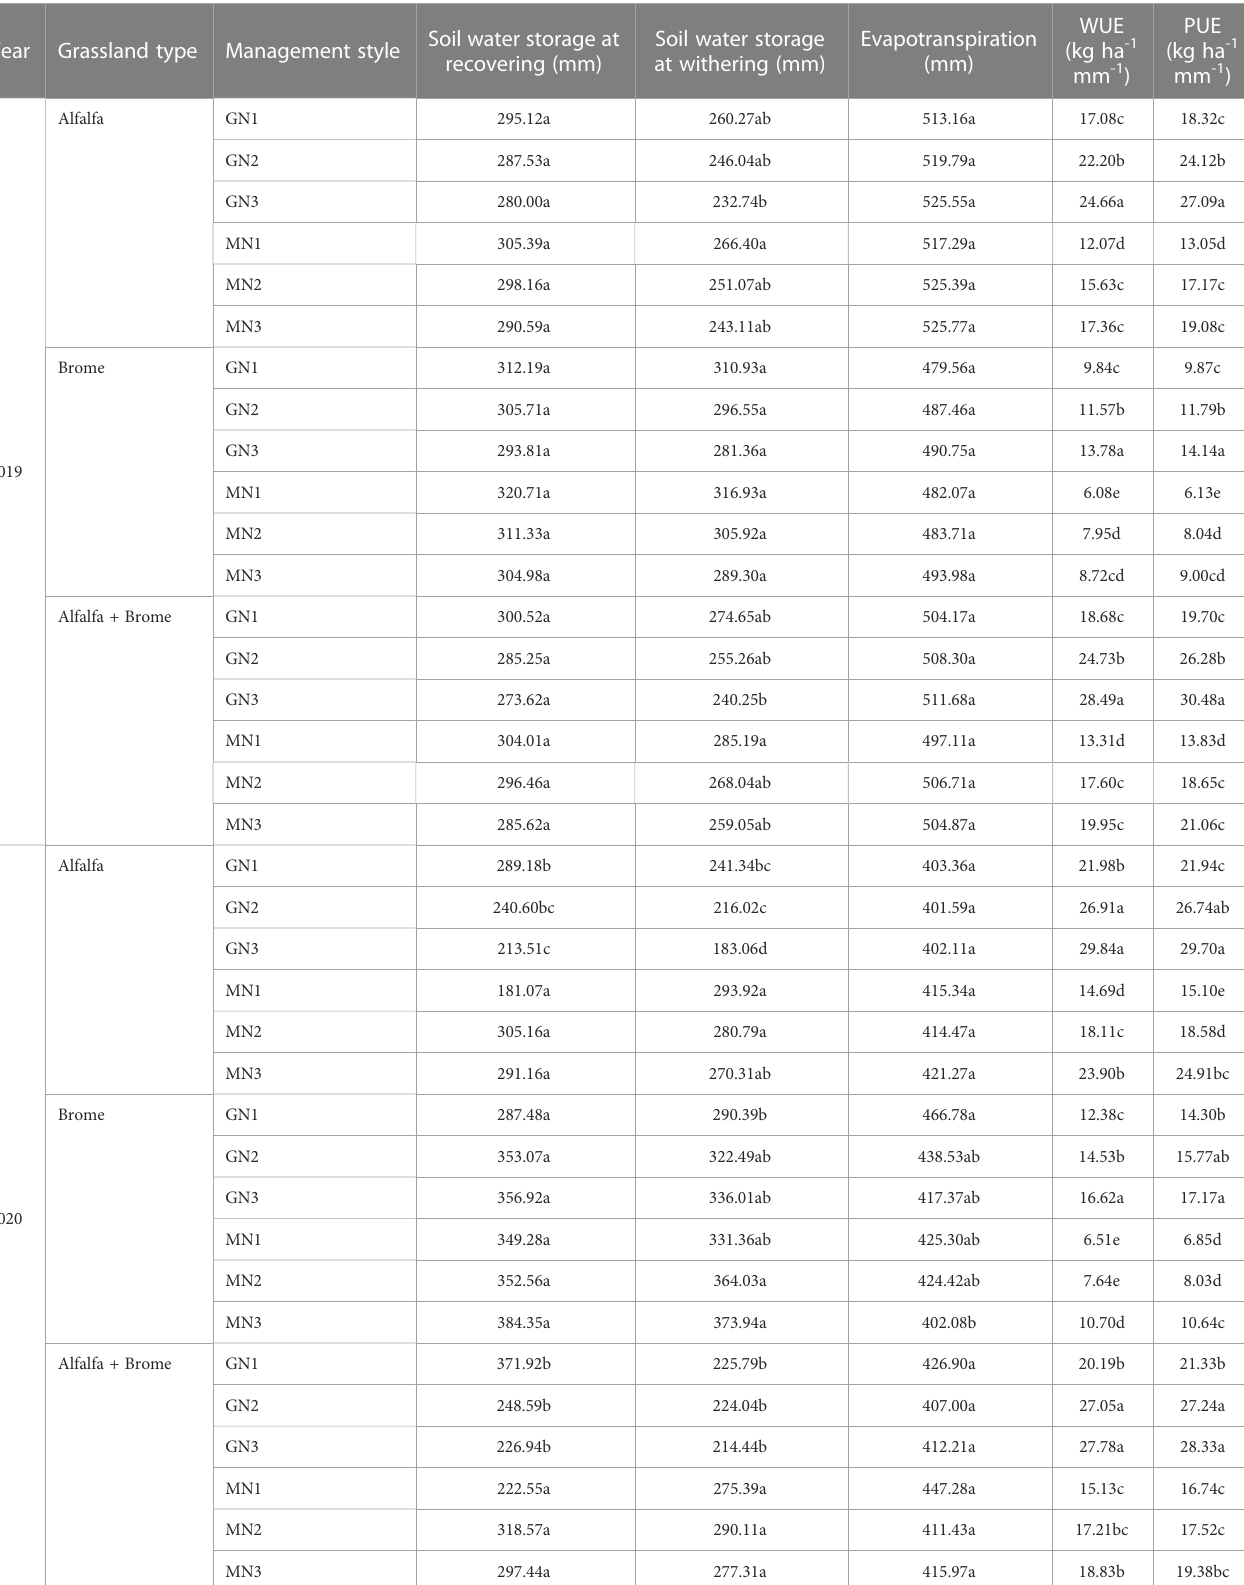
TABLE 3 Soil water storage, evapotranspiration, water use ef fi ciency (WUE) and precipitation use ef fi ciency (PUE) under different treatments in 2019 and 2020.